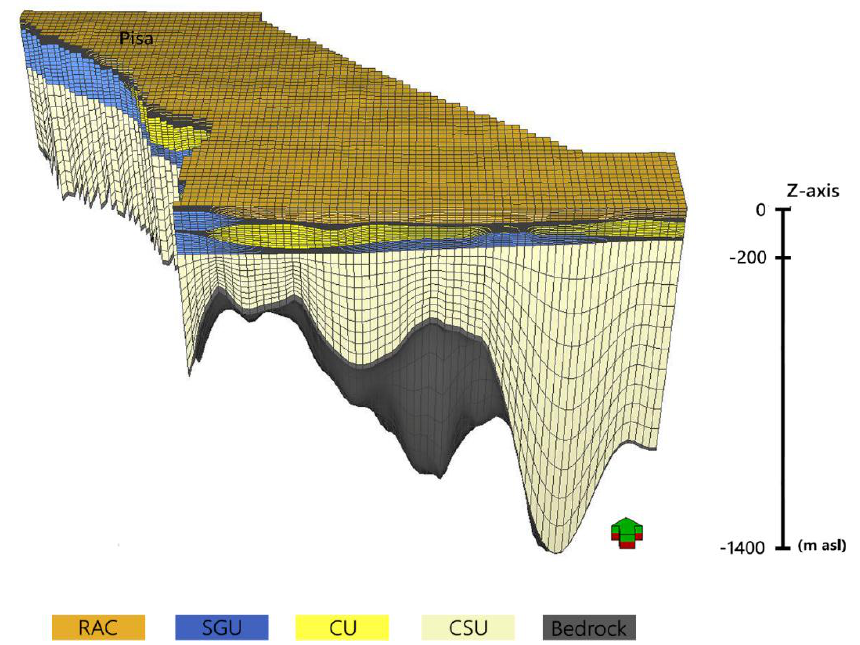
Figure 7. Section of the 3D model of the selected area. Underground vertical exaggeration: 10 × . Topographic surface vertical 2 × . RAC: recent alluvial cover; SGU: sand and gravel unit; CU: clay unit; CSU: clay and sands unit.